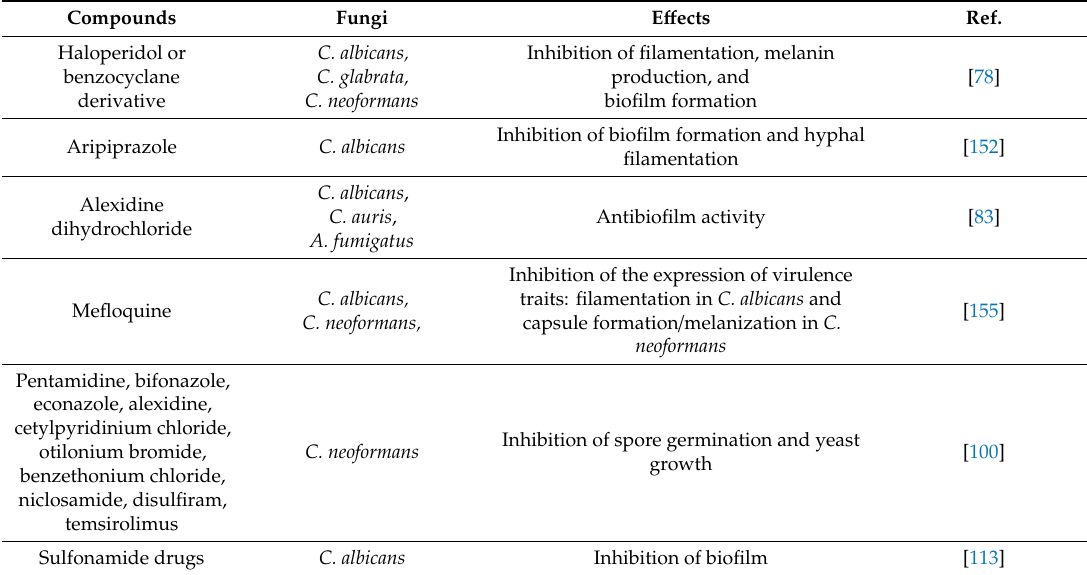
Table 2. Examples of repurposed drugs negatively a ff ecting biofilm formation, hyphal filamentation, or yeast growth in